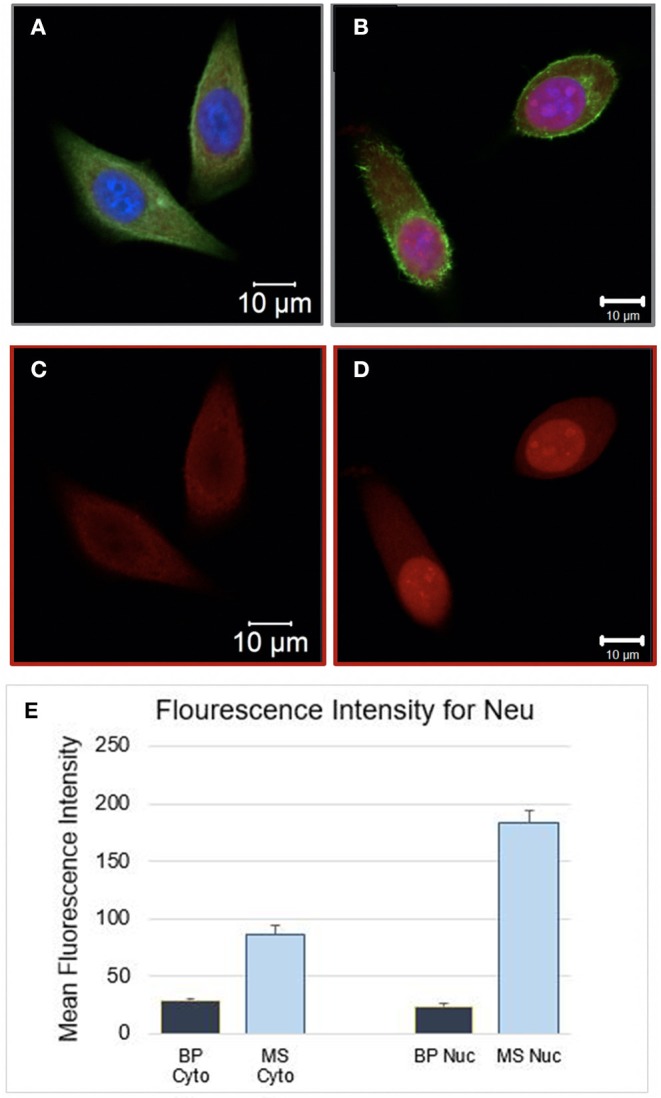
(A) Bioprinted MCF7 cells 24 h post-BP. Image showing in all three channels. (B) Manually Seeded MCF7 fixed at 24 h post seeding. (C) Bioprinted MCF7 Cells and (D) manually seeded MCF7 cells, single channel image, stained with Neu (sc-33684) primary antibody and goat IgG anti-mouse secondary conjugated with Alexa 568 channel. The same parameter settings were used for both cell samples. Fluorescent Intensity measurements were significantly different between the two samples, cytosol and nucleus were measured separately. In (E) Mean intensity measurements for the cytosol and the nucleus of the BP cells were 28.9 (1.6) and 24.3 (1.7), respectively. The mean intensity measurements for the cytosol and nucleus of MS cells were 87.0 (7.4) and 183.6 (9.8), respectively (BP Cyto = BP Cytosol, MS Cyto = Manually Seeded Cytosol, MS Nuc = Manually Seeded Nucleus, BP Nuc = BP Nucleus).